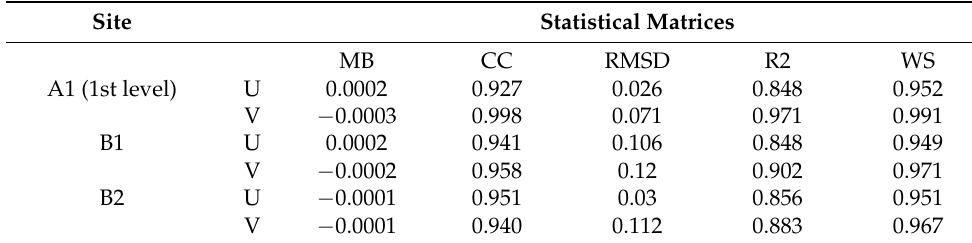
Table 3. Statistics of tidal currents (M2, S2, O1, and K1 constituents) for A1, B1, and B2.